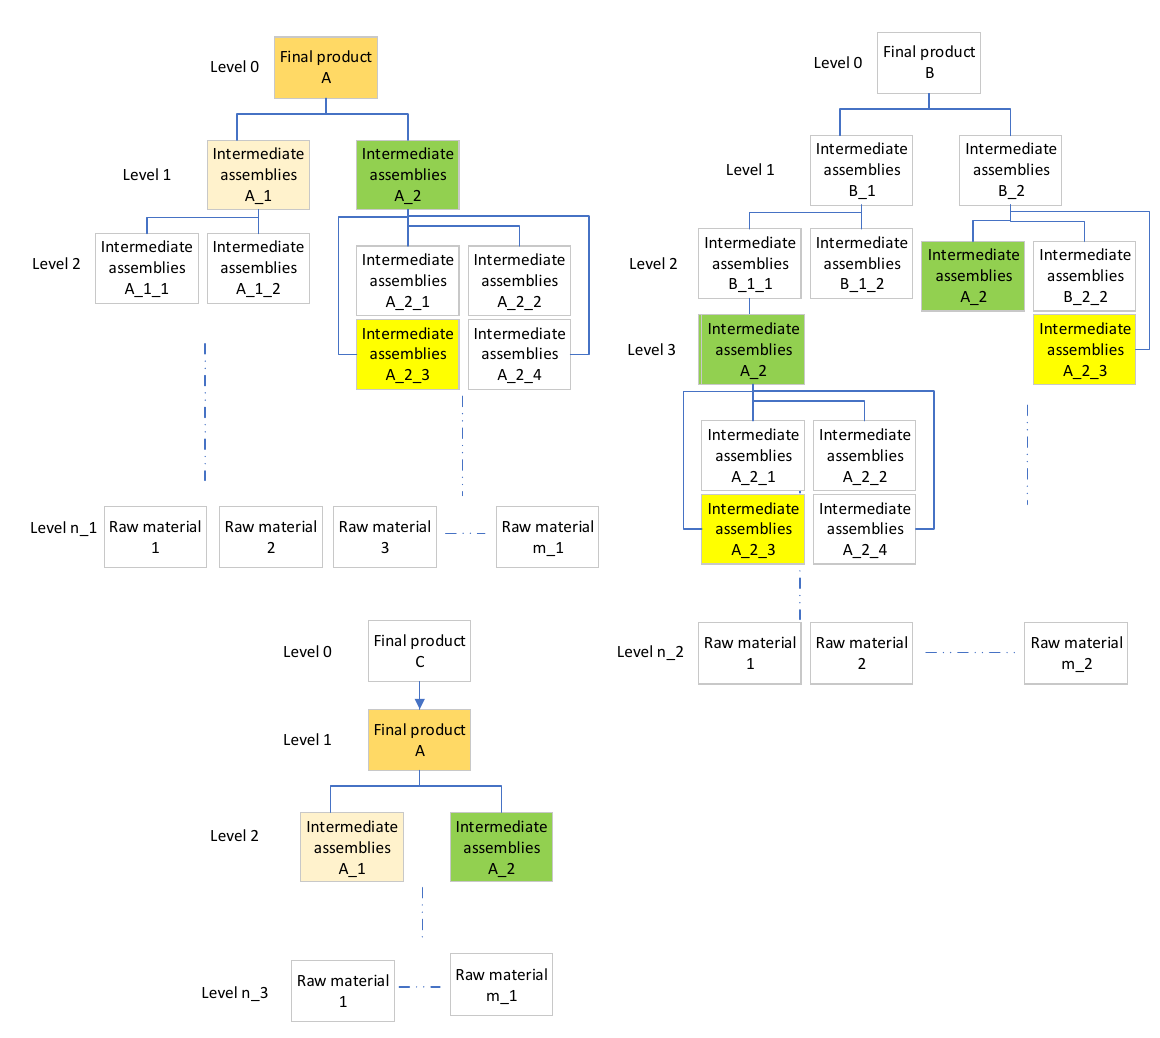
Figure 2. An example of multi-level BOMs in which the intermediate assemblies are repeated at different levels (highlighted in different shades of yellow). The best candidate for a key intermediate good is highlighted in